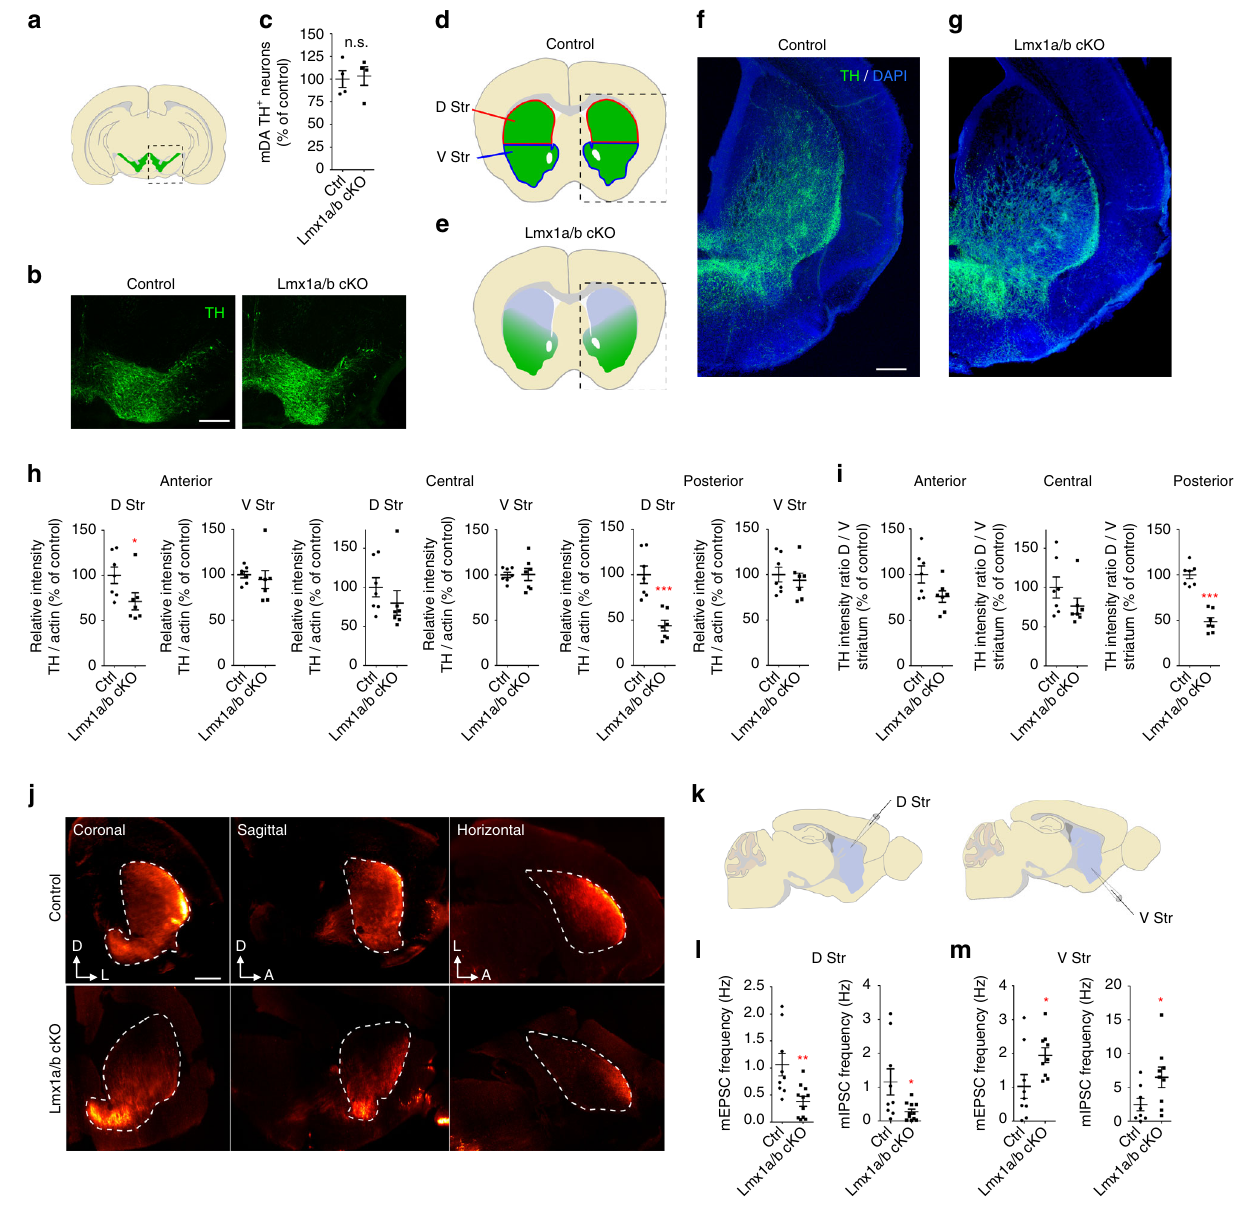
Fig. 2 Characterization of the phenotype of Lmx1a/b double conditional mutant mice at P1. a Schematic representation of coronal section of mouse brain at the midbrain level at post-natal day 1 (P1). Dashed line indicates the delimitation of the pictures shown in b . Distribution ( b ) and number ( c ) of mDA neurons in the midbrain were not different between controls and Lmx1a/b cKO at P1 ( n = 4, two-tailed unpaired t test, p = 0.8134). d , e Schematic representations of axonal innervation in the striatum in control and Lmx1a/b cKO mice brains at P1. f , g Representative confocal images of control and Lmx1a/b cKO mice brain sections showing a loss of dopaminergic innervation in dorso-posterior striatum for Lmx1a/b cKO mice (TH in green and DAPI in blue). h , i Optical density measurements of TH axons in the striatum. Graphs in ( i ) show the ratio of TH intensity in dorsal vs. ventral striatum ( n = 7, two-tailed unpaired t test, p (Ant D) = 0.0483, p (Cent D) = 0.3398, p (Cent V) = 0.9596, p (Post D) = 0.0003, p (Post V) = 0.5914, p (Ant D/V) = 0.0526, p (Cent D/V) = 0.1863, p (Post D/V) ≤ 0.0001, Mann – Whitney U , p (Ant V) = 0.1649). j Light-sheet scans of the TH immunostaining in the striatum of iDISCO-cleared brains from control and Lmx1a/b cKO mice. The panels show single optical planes in coronal and reconstructed sagittal and horizontal planes showing the lack of TH axons in the dorsal striatum of the Lmx1a/b cKO mice brains. Dotted lines delineate the border of the striatum. k Schematic representation of the location of electrophysiological recordings in the striatum. l , m Analysis of the frequency of miniature excitatory post-synaptic currents (mEPSC) and miniature inhibitory post-synaptic currents (mIPSC) in dorsal and ventral striatum (dorsal striatum: n = 9 cells for controls and n = 11 cells for Lmx1a/b cKO, Mann – Whitney U , p (mEPSC) = 0.0078; p (mIPSC) = 0.0275; ventral striatum: n = 9; two-tailed unpaired t test; p (mEPSC) = 0.0408; p (mIPSC) = 0.0444). Scale bars: 250 µ m for ( b ), ( f ), ( g ) and 500 µ m for ( j ). D, dorsal; L, lateral; N.S., not signi fi cant; Str, striatum; V,